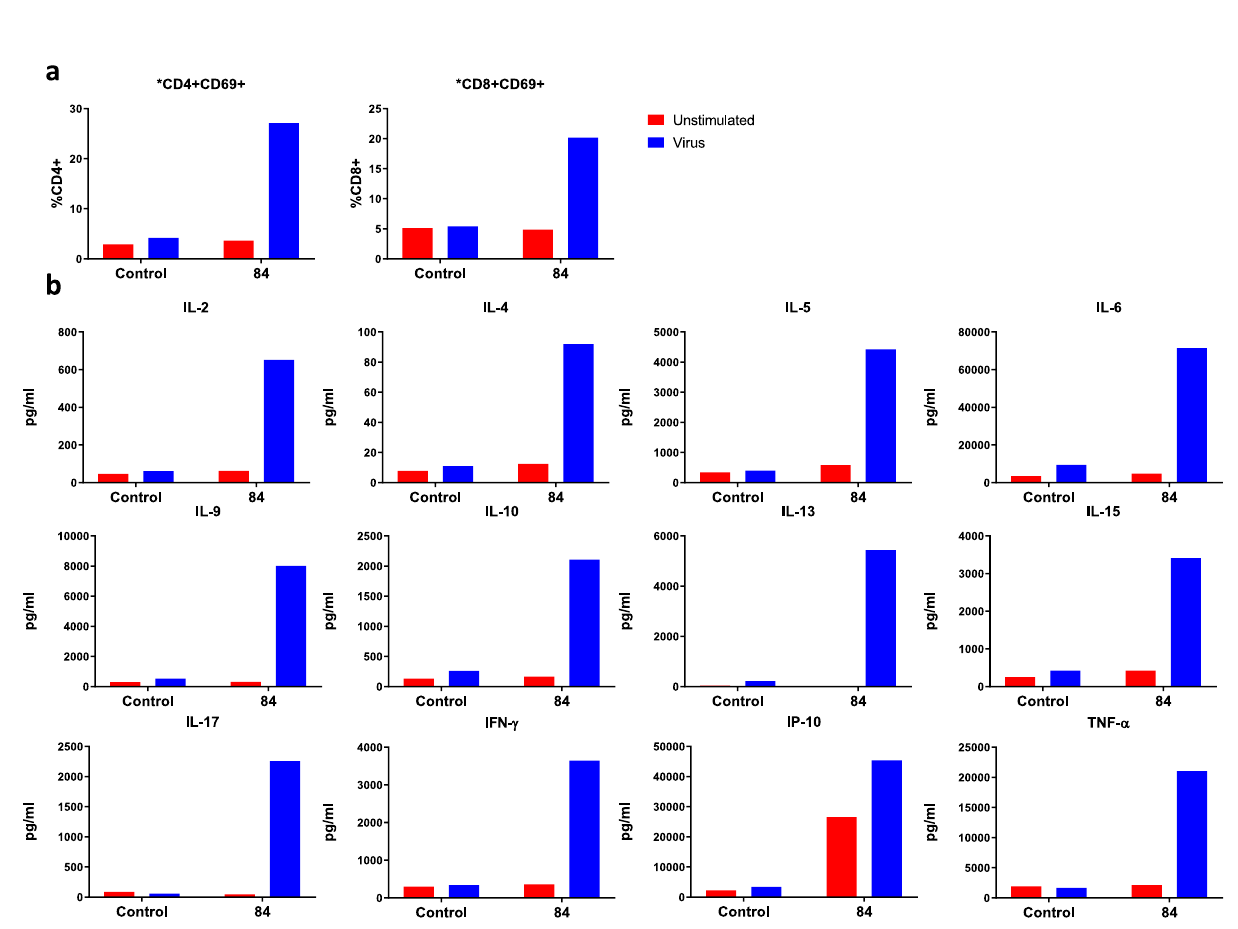
Fig. 3 Immune response to inactivated SARS-CoV-2. A Flow cytometry was performed on PBMCs following 4-day stimulation with inactivated SARS- CoV-2 to observe T-cell activation status. CD69 + was expressed as a proportion of total CD4 + or CD8 + T-cells. B Cytokines were quanti fi ed in PBMC supernatants following 4-day stimulation with inactivated SARS-CoV-2 by multiplex cytokine assay to assess memory T-cell